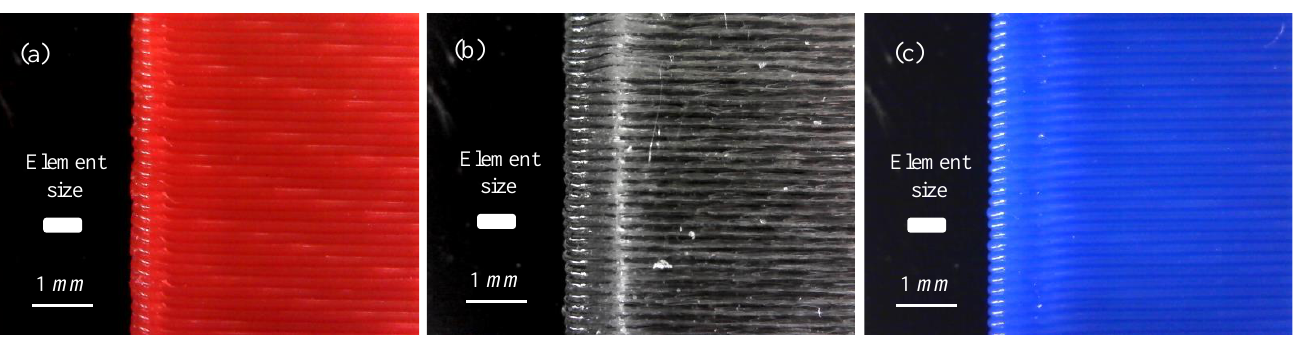
Figure 15. Edge samples to estimate the gap (if any) at the end of each layer of ( a ) ABS, ( b ) PC, and ( c )